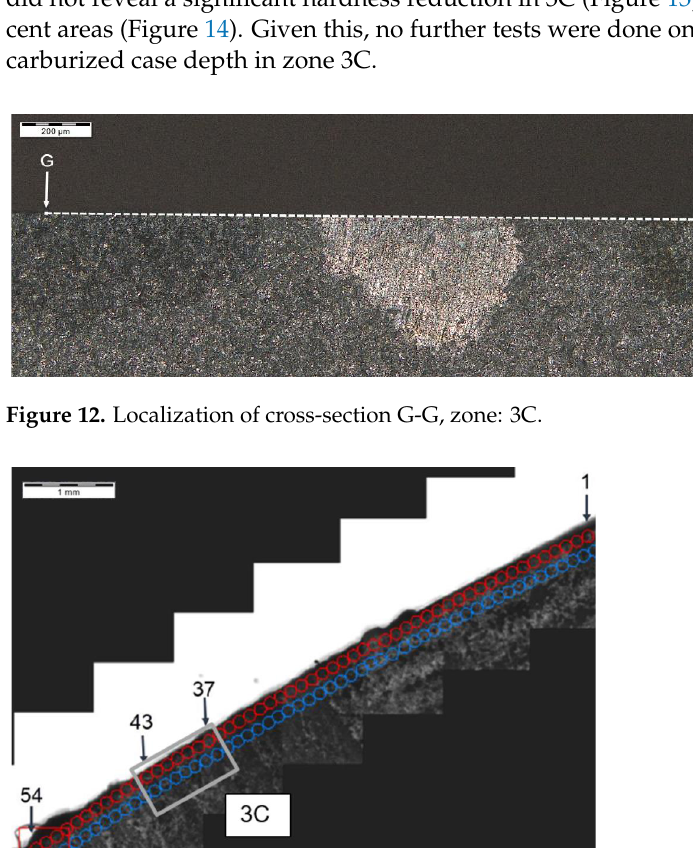
Figure 11. Waviness of carburized case depth. Magnification: 12.5×. Cross-section F-F, zone: 3A. Etched sample — Nital 5%.